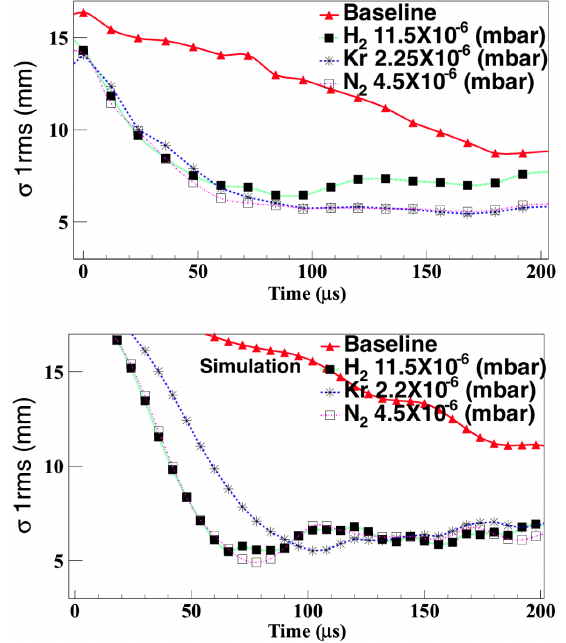
FIG. 19. Beam size (rms) along the beam pulse, measured (top) and simulated (bottom) for three different injected gases.